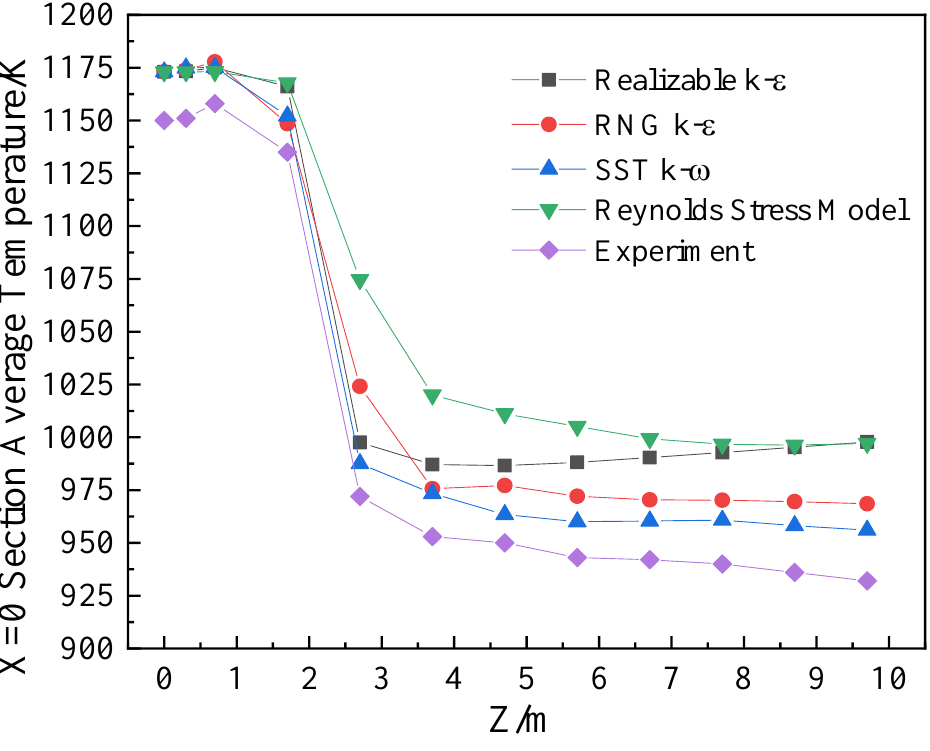
Figure 7. Model independence verification.